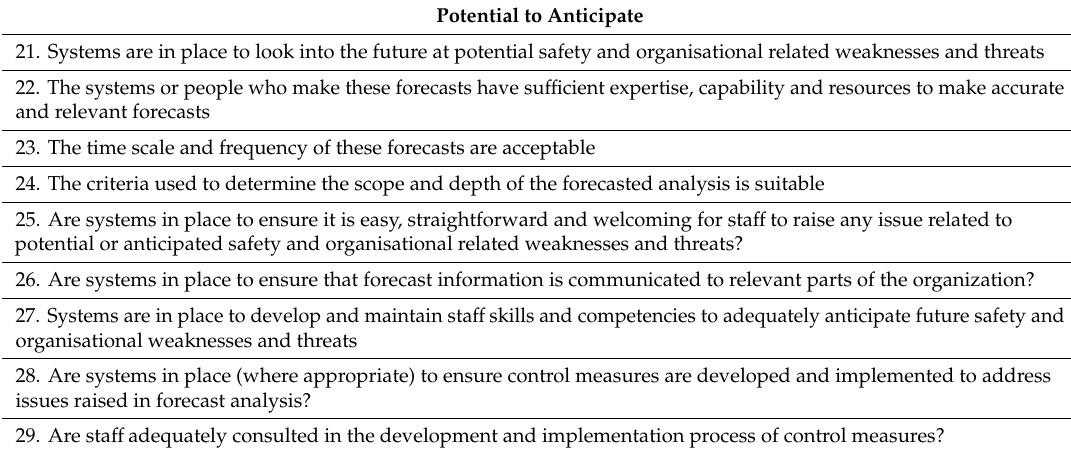
Table 4. Potential to Anticipate survey